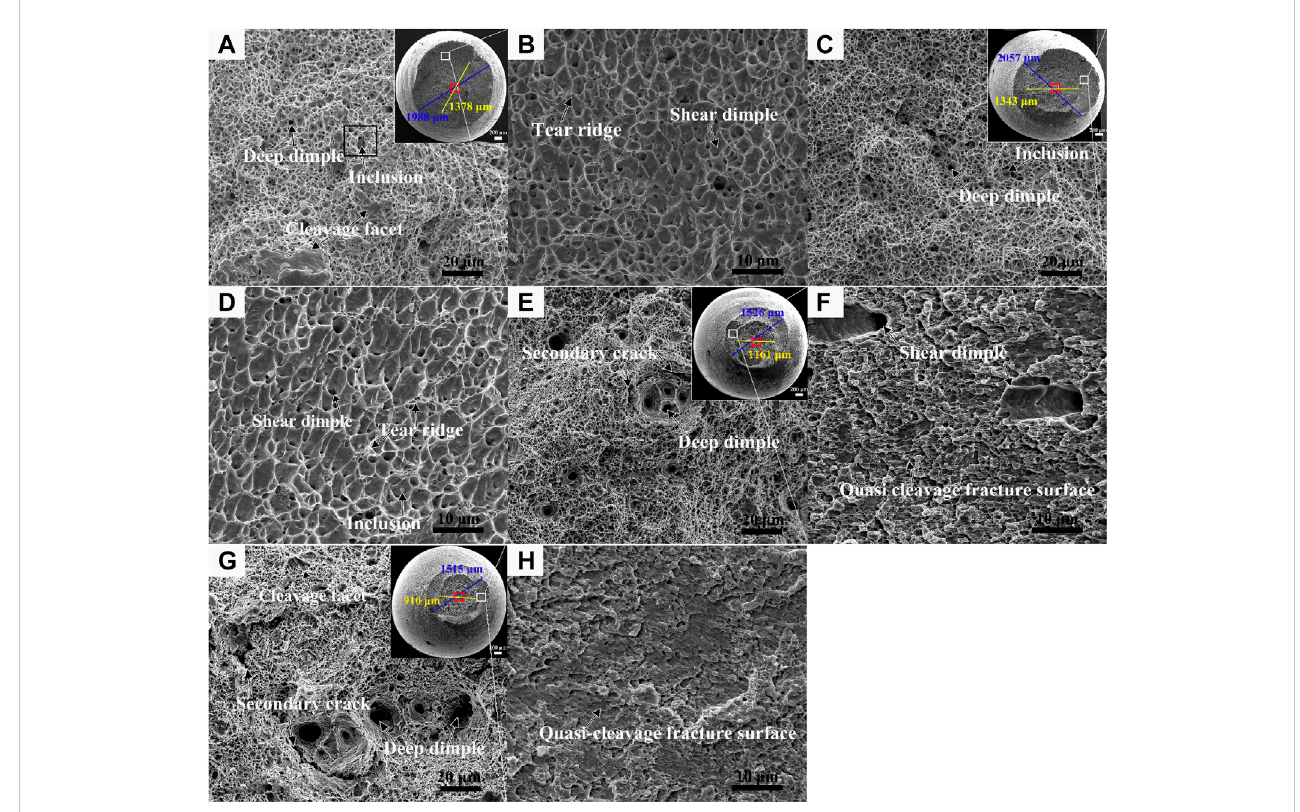
FIGURE 3 Top view and detailed view of the tensile tested fracture surface. For the WM in , (A) the fi ber zone and (B) the shear-lip zone; for the WM mid , (C) the fi ber zone and (D) the shear-lip zone; for the HAZ, (E) the fi ber zone and (F) the shear-lip zone; and for the BM, (G) the fi ber zone and (H) the shear-lip zone.